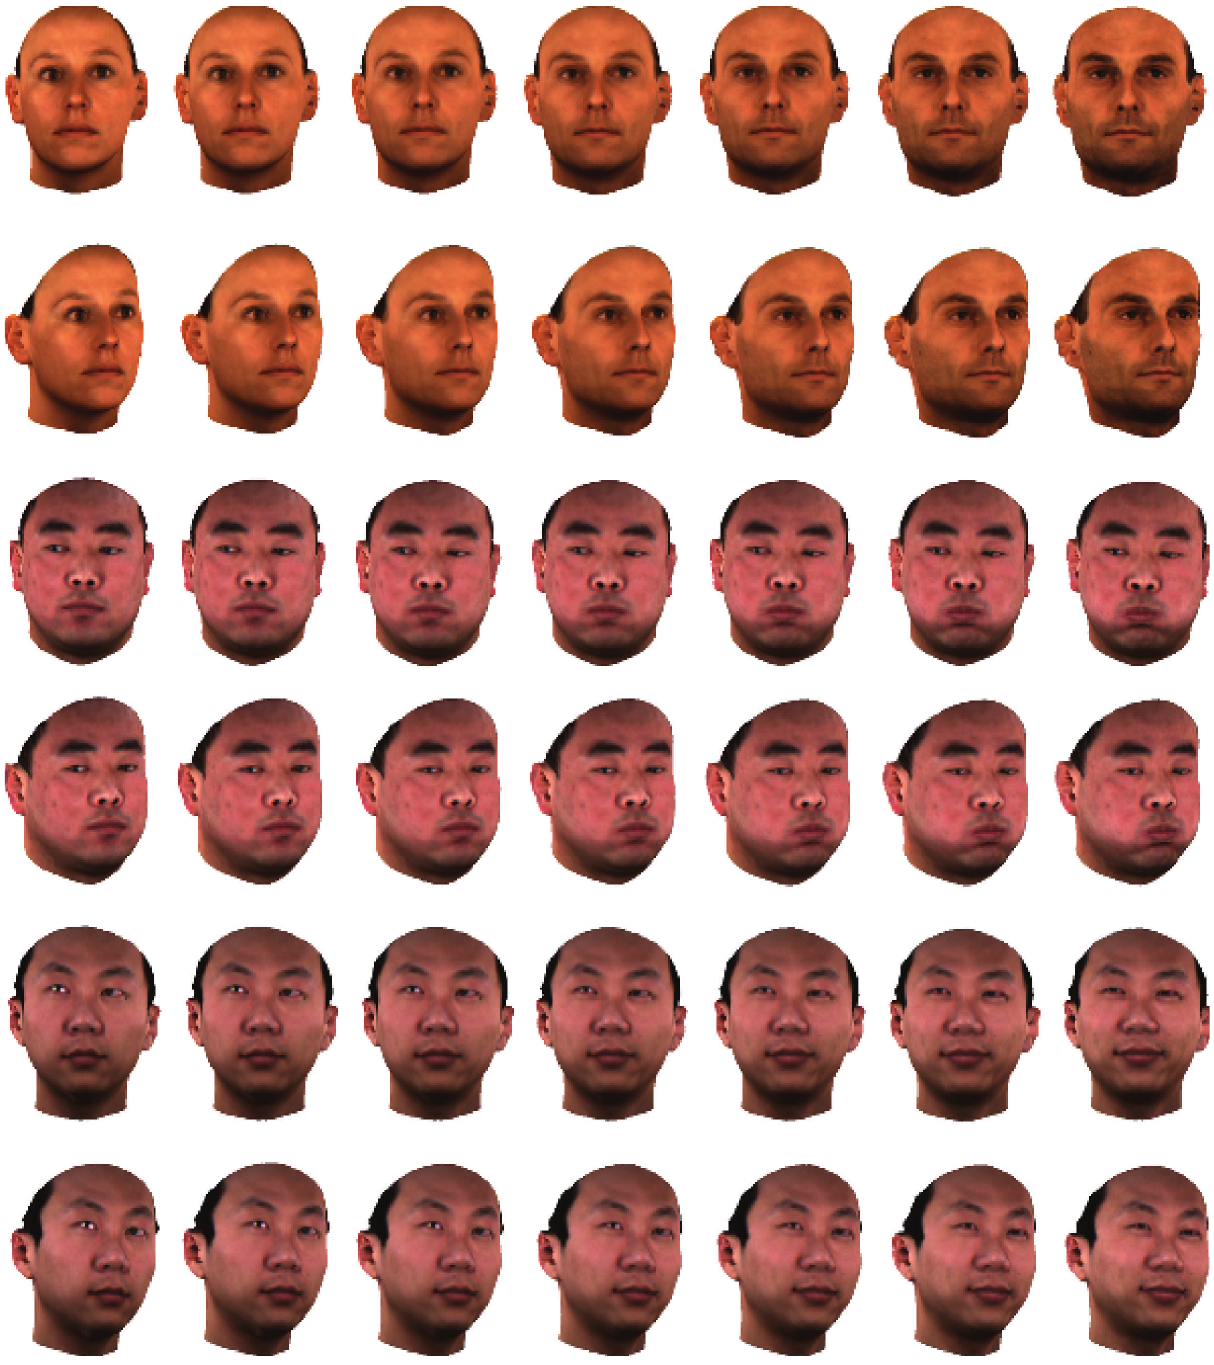
Figure 7: The sequence of 3D face morphing and animation. The left column and the right column are the source 3D faces and the destination 3D faces. The top two rows are the middle frames morphing a female 3D face to a male 3D face selected from MPI 3D face database. The middle two rows are the animation sequence of a person from the neutral state to an aspiratory action state. The bottom two rows are the animation of a person from the neutral expression to smile expression. The 3D faces in the bottom four rows are selected from BJUT-3D Face